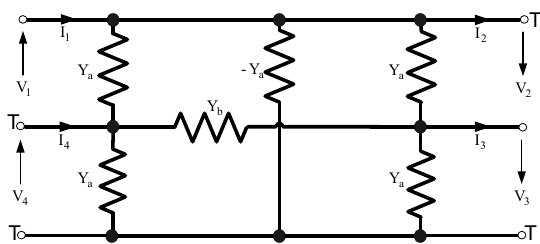
Figure 4. The equivalent circuit for the directional coupler with admittance parameters